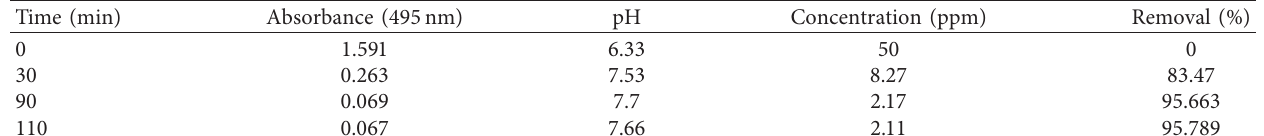
Table 5: Different characteristic values as a result of dye treatment through